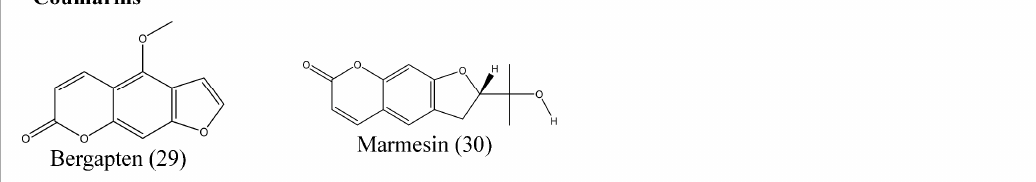
Figure 3. Structures of flavonoids and coumarins isolated from desert